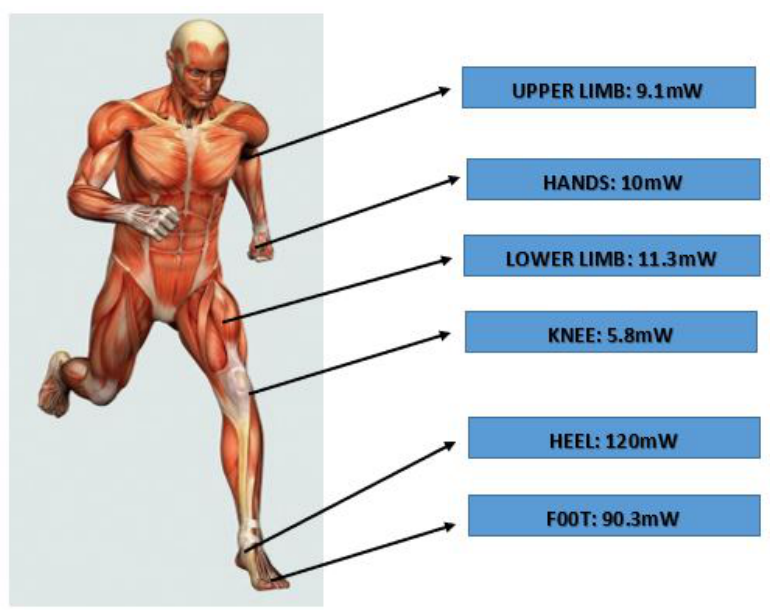
Figure 15. Piezoelectric energy harvesting from the human